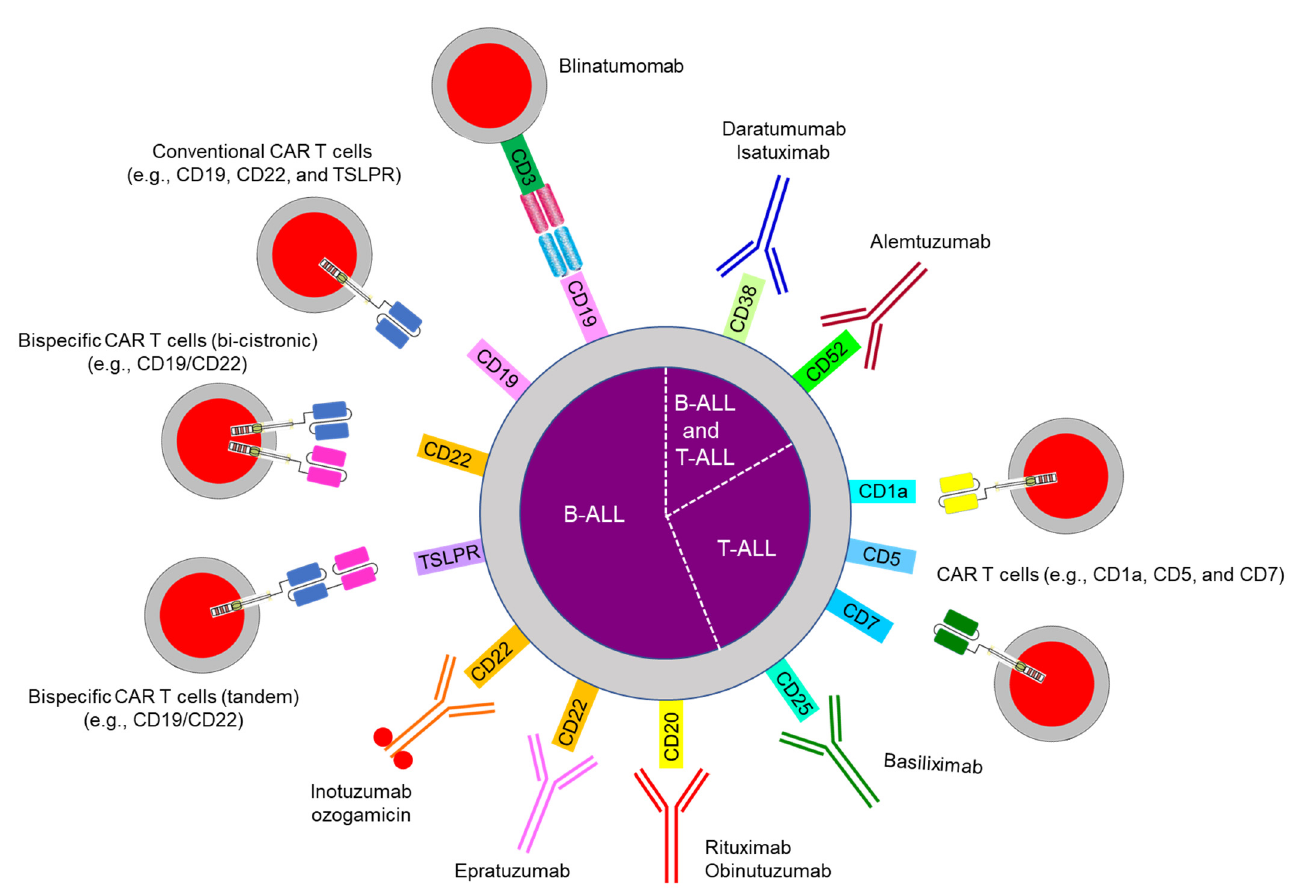
Figure 3. Immunotherapy in acute lymphoblastic leukemia. Abbreviations: ALL, acute lymphoblastic leukemia; CAR, chimeric antigen receptor; TSLPR, thymic stromal lymphopoietin receptor.